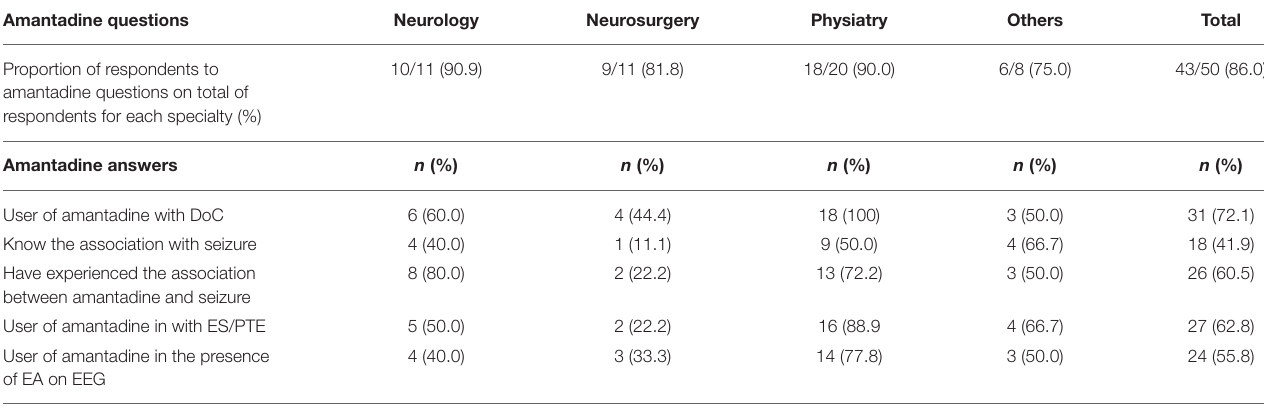
TABLE 1 | Proportion of respondents to amantadine questions based on medical specialties and their